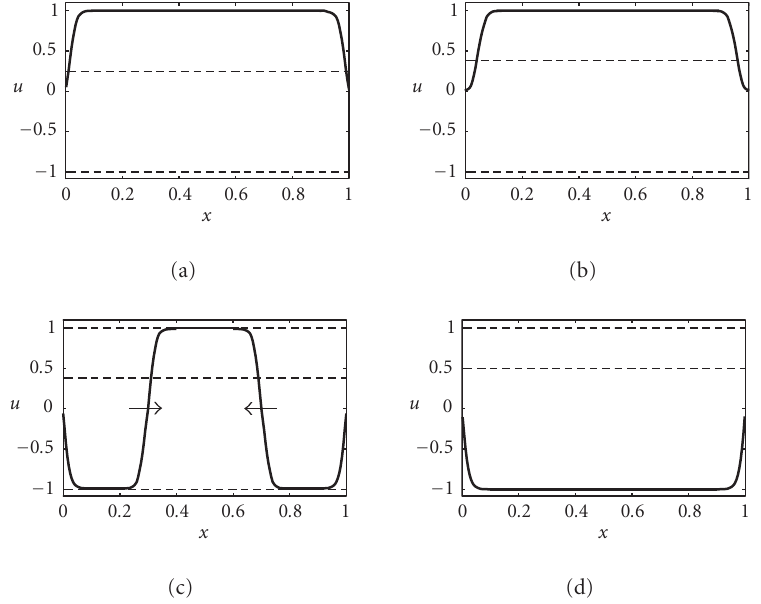
Figure 3.2. Sample phases of the periodic behavior illustrating the switching between upper and lower boundary layer type